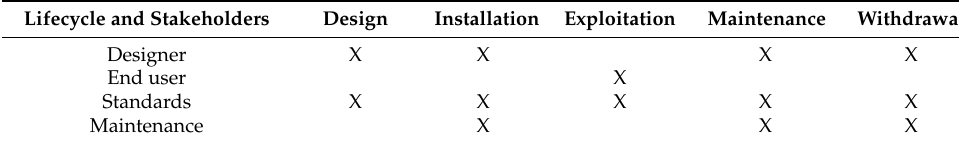
Table 2. Stakeholders’ participation in the lifecycle phases.